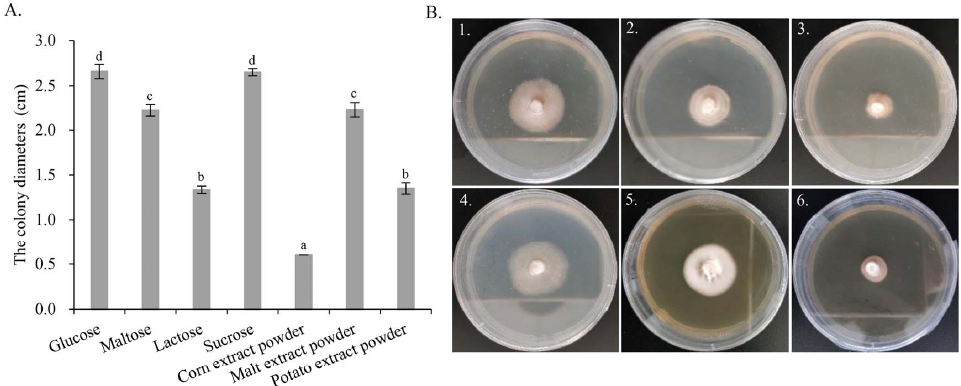
Figure 7. The colony diameters and morphology of G. purpuraceus cultured on different carbon sources. ( A ) Colony diameters. Different letters on the column indicate a significant difference ( p < 0.01). ( B ) Morphology of G. purpuraceus on different carbon sources after 60 days of cultiva- tion: (B1) glucose, (B2) maltose, (B3) lactose, (B4) sucrose, (B5) malt extract powder, (B6) potato extract